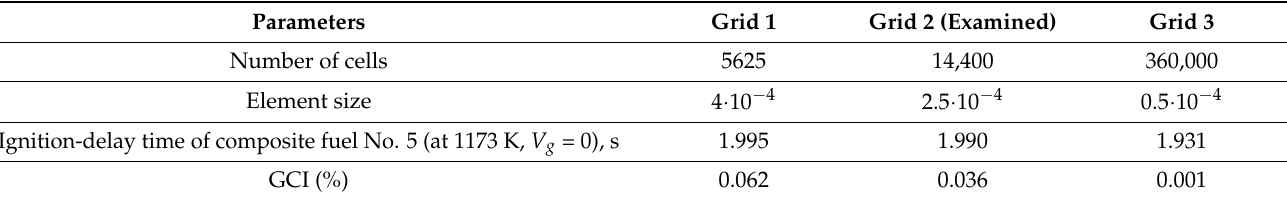
Table 7. Grid convergence analysis.